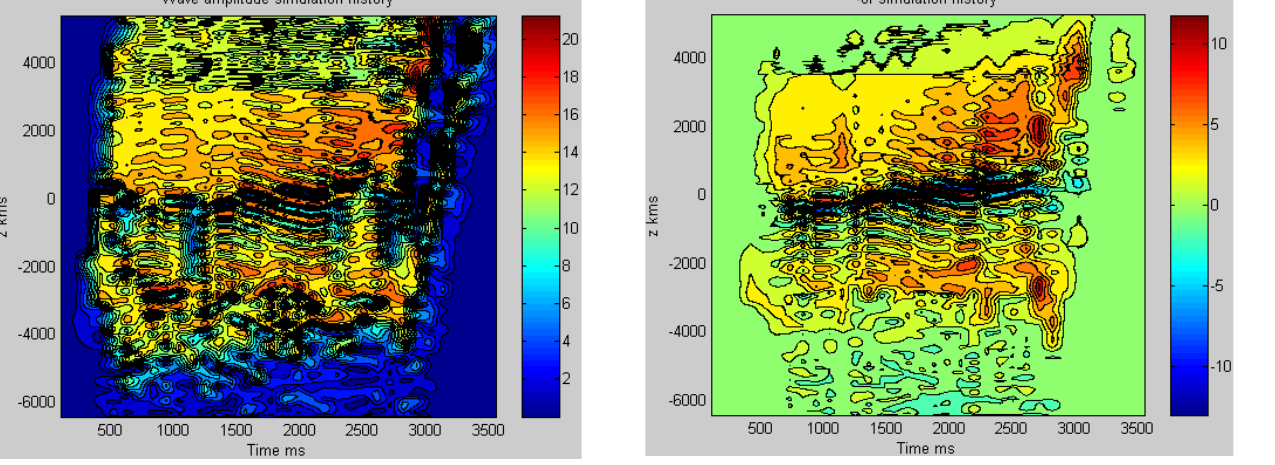
Fig. 17. Wave amplitude history (in pT) of the simulation as a con- tour plot in the z,t plane, for the case of falling chorus. The struc- ture has high nonlinear growth rates and the wave amplitude extends 4000km upstream from the equator.